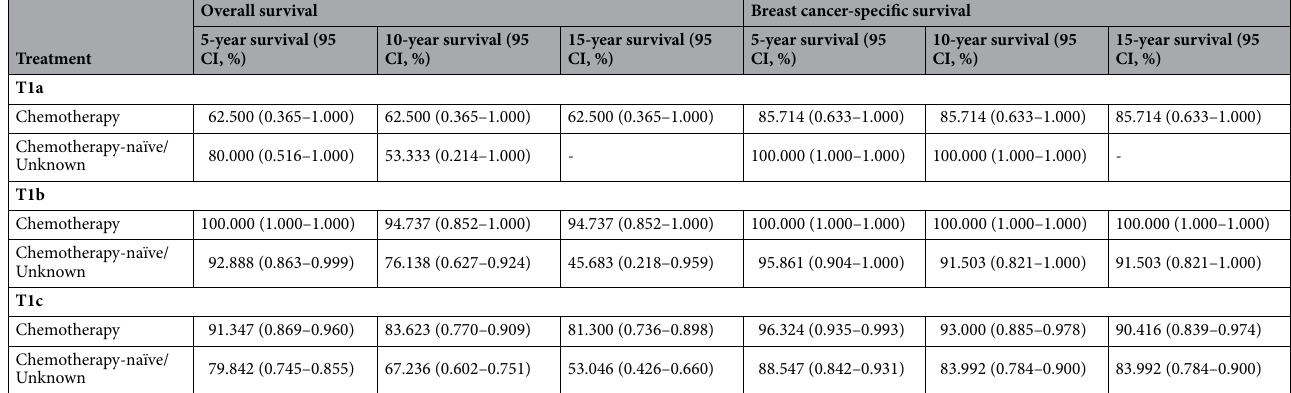
Table 2. T1abc stage MpBC survival outcomes of patients following chemotherapy treatment or not. Abbreviations: CI, confidence